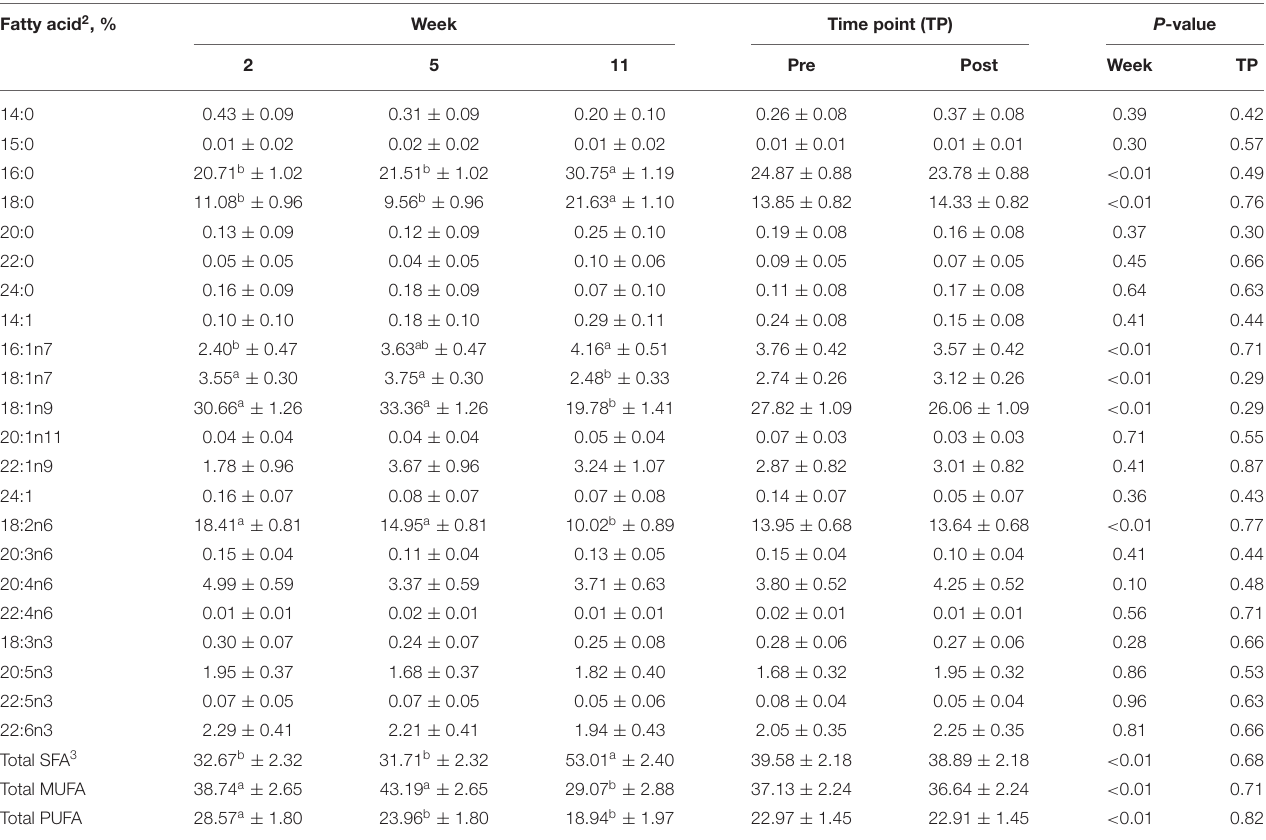
TABLE 6 | Mean fatty acid composition ( ± SE 1 ) and percent contribution of saturated fatty acids (SFA), monounsaturated fatty acids (MUFA), and polyunsaturated fatty acids (PUFA) for the triacylglycerol (TAG) fraction identified in serum of all dogs at weeks 2, 5, and 11 (pooled across pre- and post-exercise sampling time points) and at the pre- and post-exercise sampling time points (pooled across weeks 2, 5, and 11). Fatty acid 2 ,